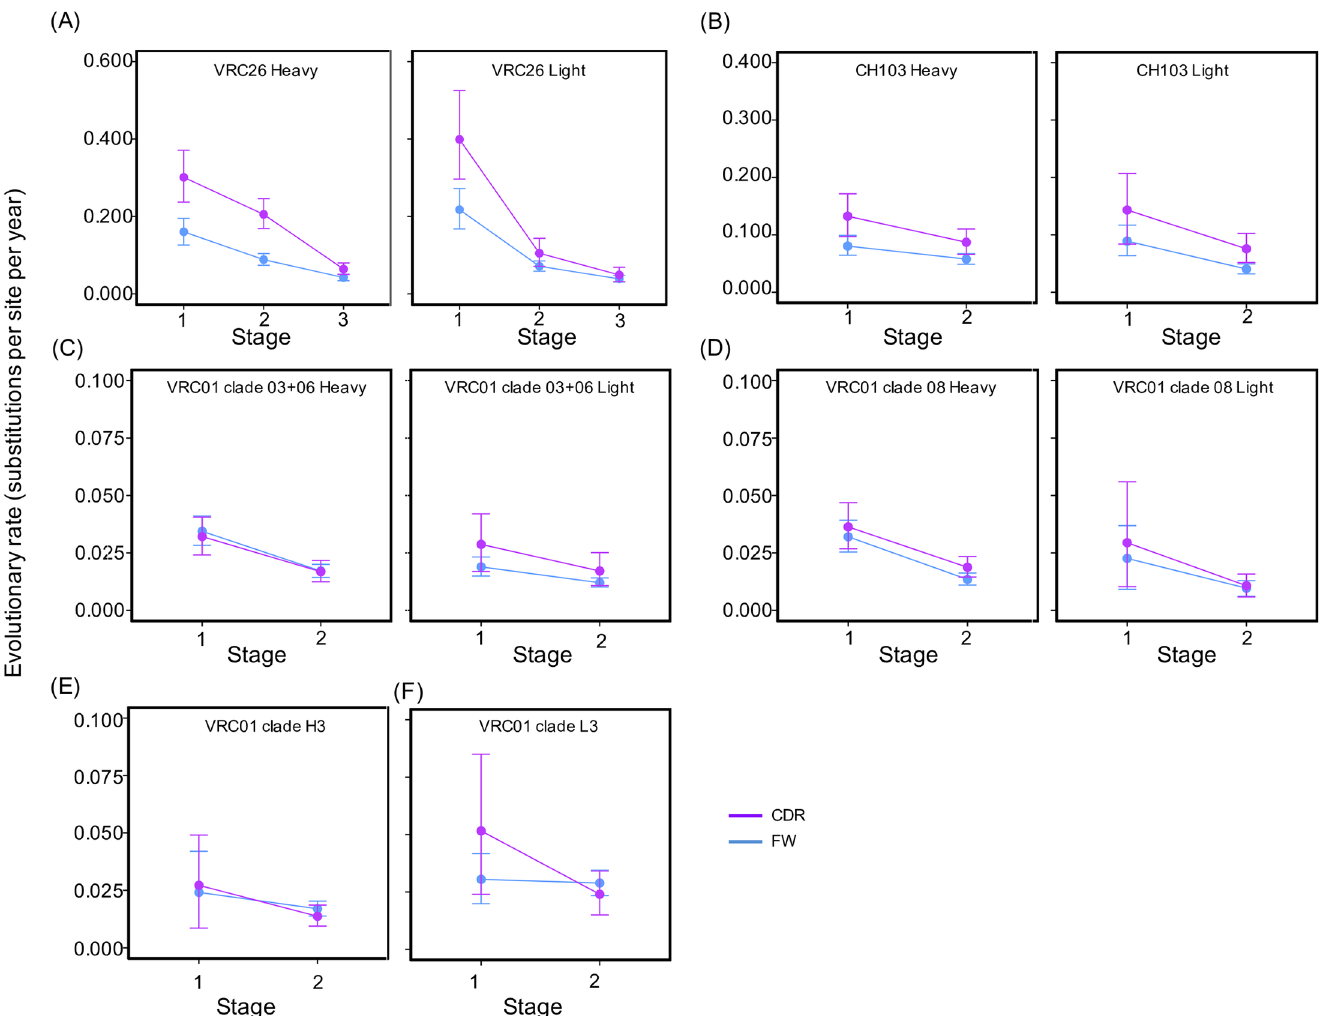
Fig 5. The evolutionary rates of CDRs and FWRs of the three lineages decrease over time. The mean and 95% highest probability density interval (HPD) are shown for each stage. Stages from the same chain of a lineage are connected to reveal longitudinal trend. The plots of CDR regions are colored magenta while plots of FWRs are colored blue. (A) The mean evolutionary rates for the CDRs and FWRs of the VRC26 heavy (left) and light (right) chains showed about 80% decrease over the study period. (B) The mean evolutionary rate dynamics for the CDRs and FWRs of the CH103 heavy (left) and light (right) chains showed about 45% decrease over the study period. (C) Evolutionary rate dynamics for the CDRs and FWRs of the VRC01 clade 03+06 heavy (left) and light (right) chains showed about 45% decrease over the study period. But the evolutionary rate decrease for light chain CDRs is not significant. (D) Evolutionary rate dynamics for the CDRs and FWRs of the clade 08 heavy (left) and light (right) chains. The decreases in evolutionary rates are only significant for both regions in heavy chain. (E) and (F) show evolutionary rate dynamics for the CDRs and FWRs of the VRC01 clade H3 and L3, respectively. No significant decrease in evolutionary rate was detected for the two